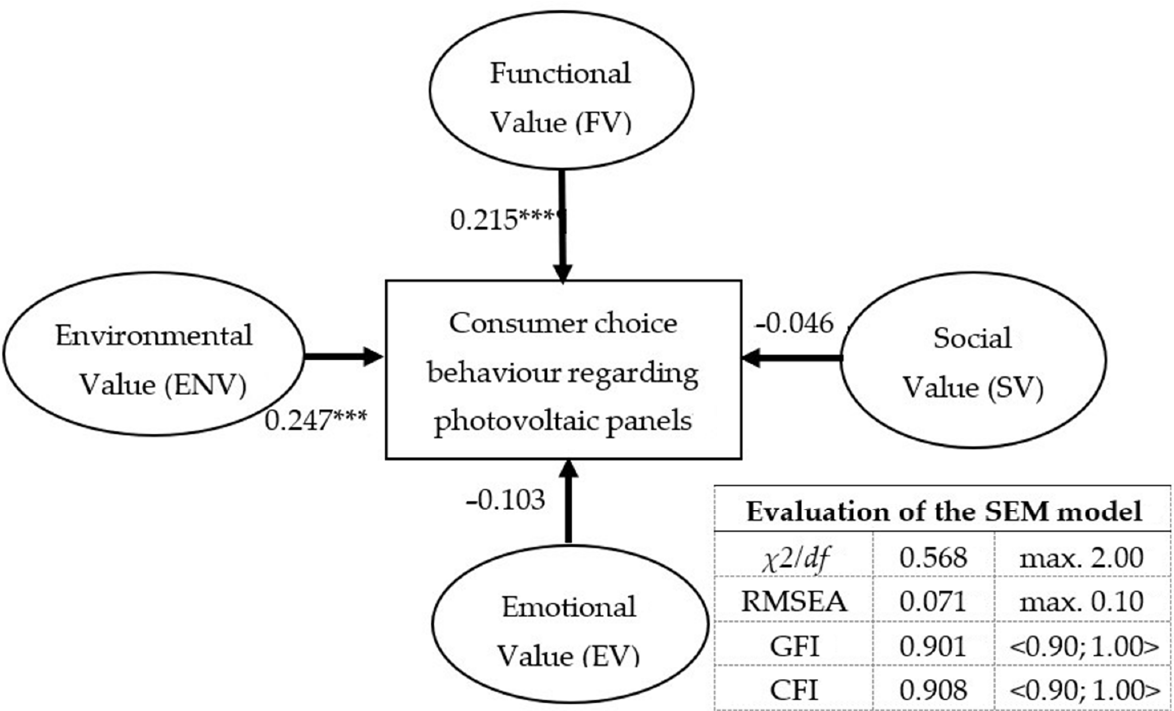
Figure 2. SEM model. Note: the SEM model differed from the conceptual model (Figure 1) in that it tested only 4 consumption values (functional, social, emotional, and environmental). The conditional value and epistemic value were not extracted through the CFA, and thus were not tested.